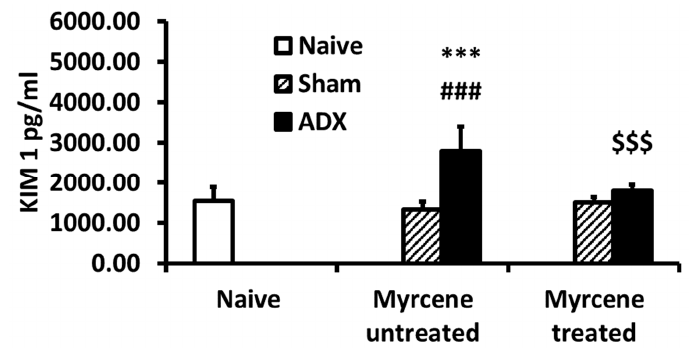
Figure 4. Quantification of Kidney KIM ‐ 1 in kidney tissue of naïve, untreated and myrcene treated ADX rats. ADX induced a significant increase in KIM ‐ 1 in the untreated ADX rats compared to the